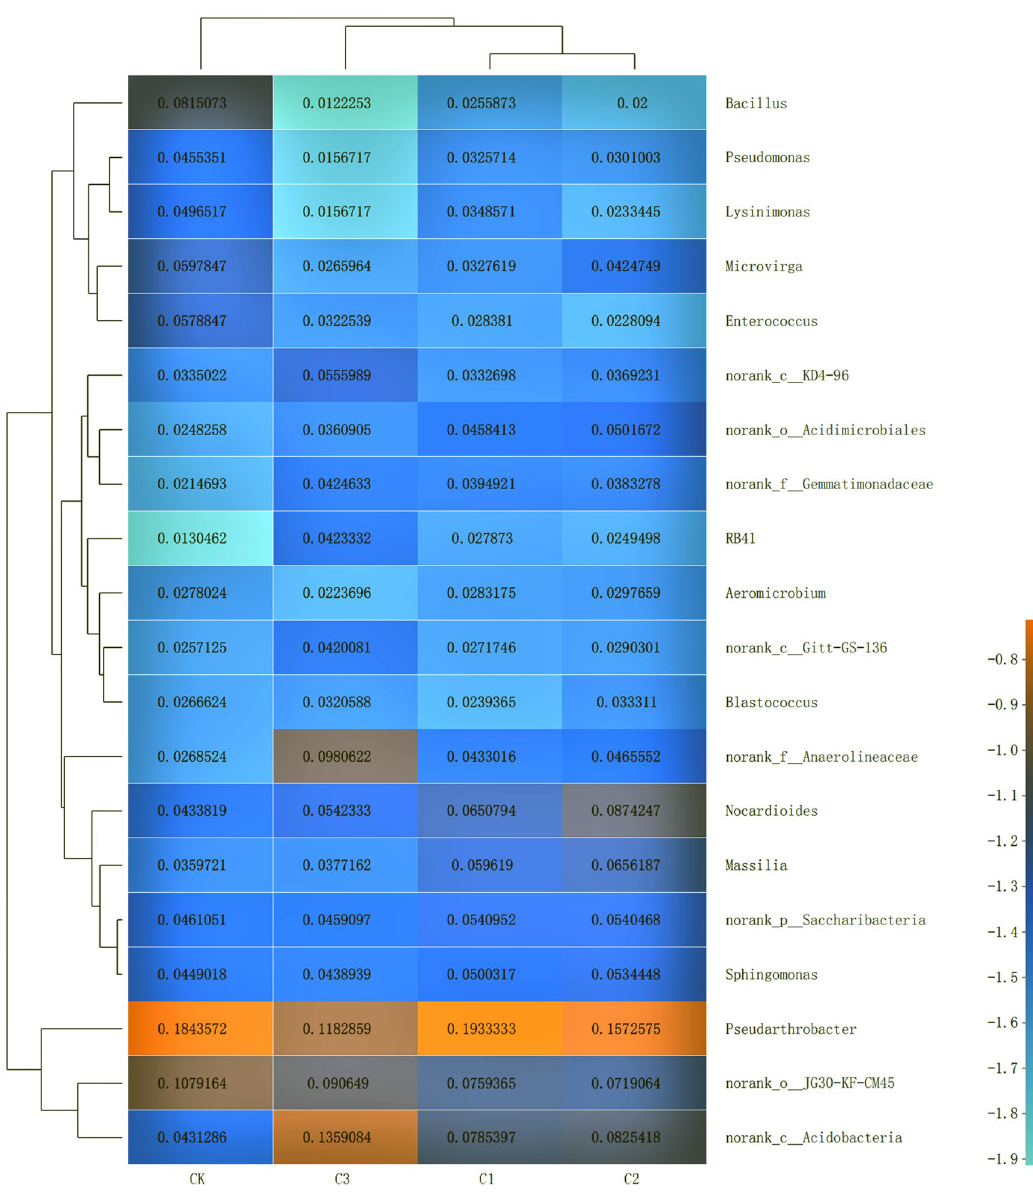
Figure 2. The abundance of soil bacteria on the Genus level in the soft rock:sand compound soil. CK, the volume ratio of soft rock to sand is 0:1; C1, the volume ratio of soft rock to sand is 1:5; C2, the volume ratio of soft rock to sand is 1:2; C3, the volume ratio of soft rock to sand is